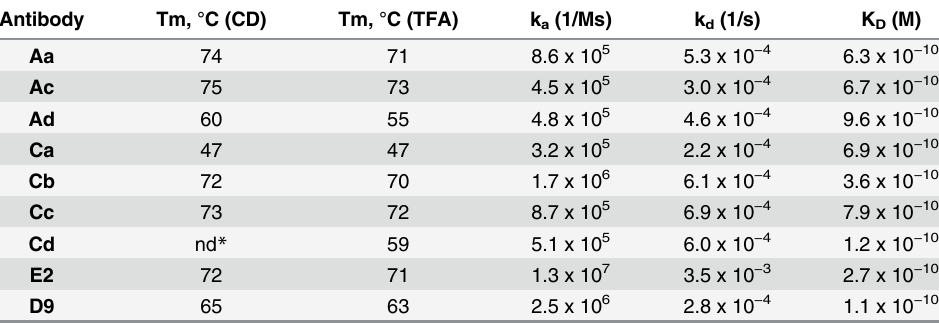
Table 2. Thermal Stability and Affinity Characterization of